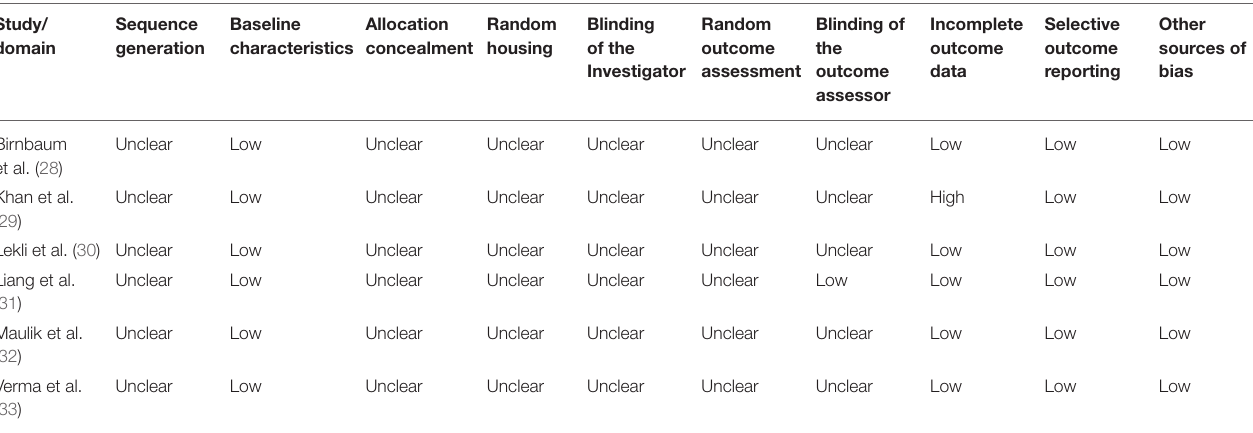
TABLE 2 | Summary of the risk of bias assessment of the included studies. Study/ domain